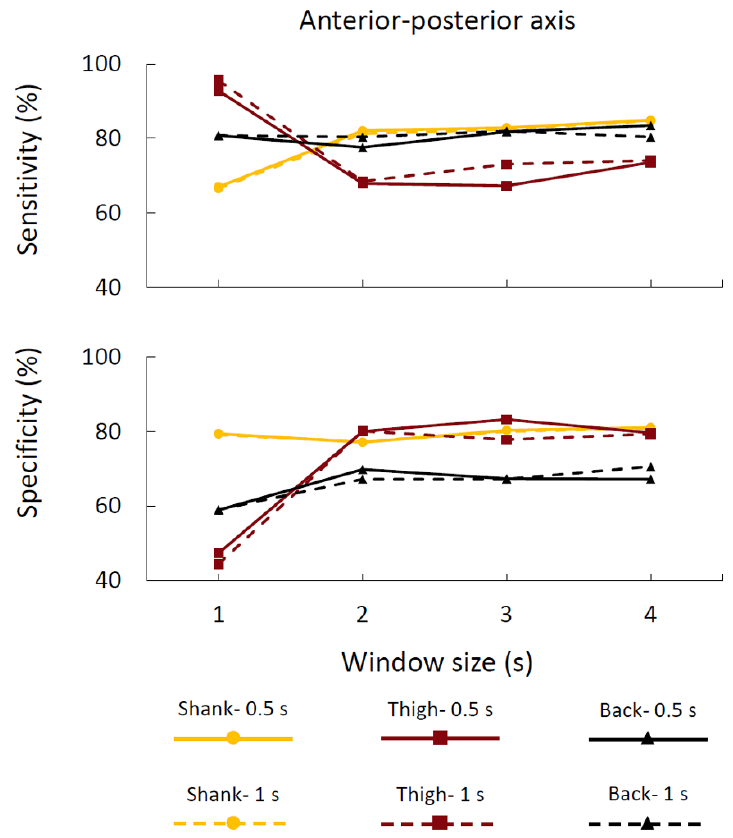
Figure 4. The averages of sensitivity and specificity across all subjects as a function of window size, update time, and sensor placement.